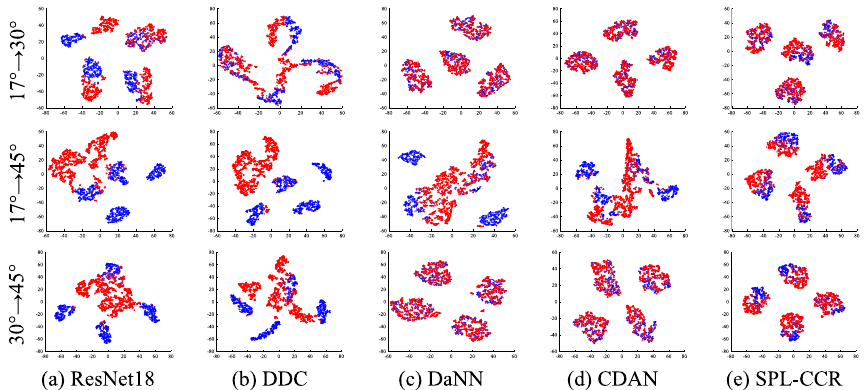
Fig. 7 Visualization of features in the output layer of each network (blue and red dots represent the source domain samples and target domain samples, respectively). a ResNet18. b DDC. c DaNN. d CDAN. e SPL-CCR. Each row corresponds to a single task, i.e., 17 ◦ → 30 ◦ , 17 ◦ → 45 ◦ and 30 ◦ → 45